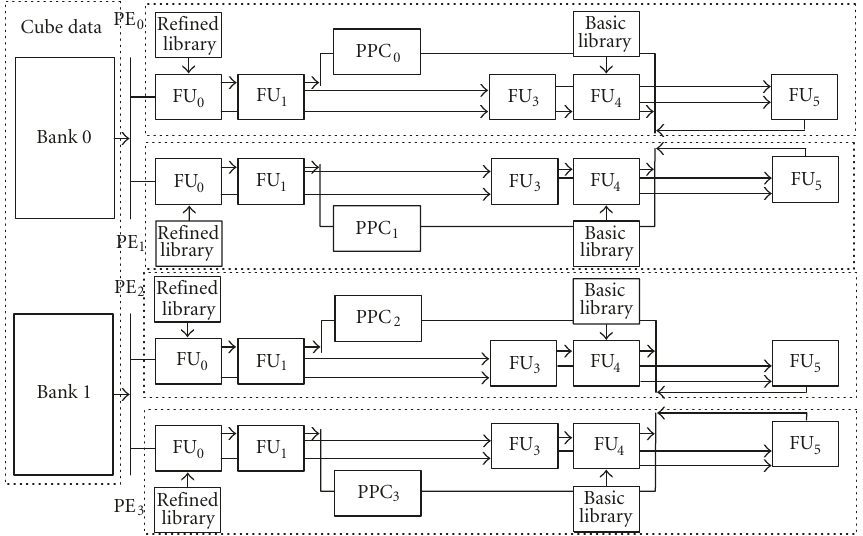
Figure 19: Illustration of the overall